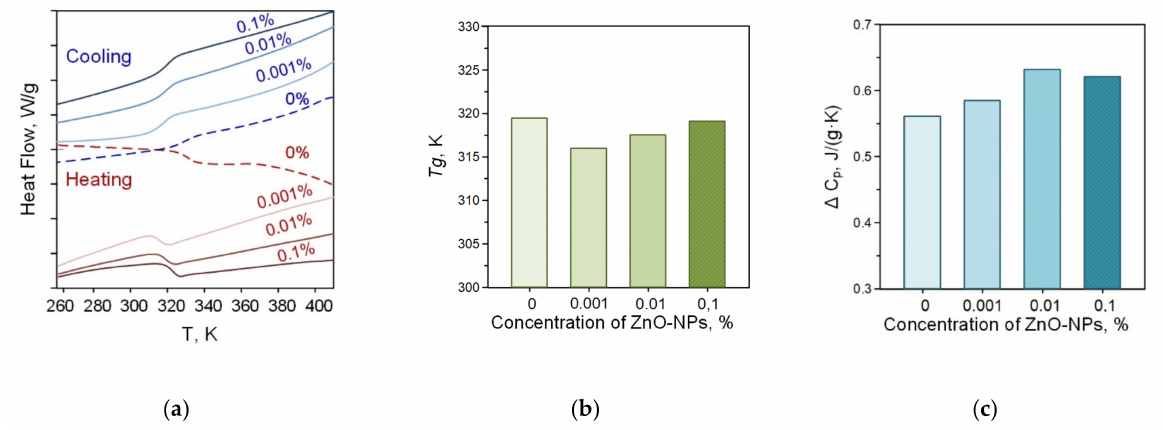
Figure 5. Thermograms of PLGA–ZnO in the heating and cooling mode ( a ); concentration dependences of changes in heat capacity ( b ); and glass transition temperature ( c ) of the PLGA–ZnO